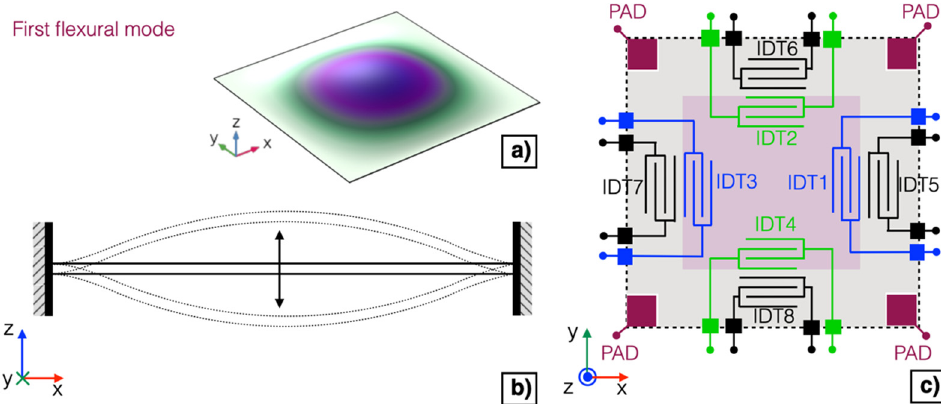
Figure 4. Displacement ( a ) and section view ( b ) of a fully-clamped square plate vibrating at the first flexural mode. Simplified schematic of the proposed piezoelectric MEMS device ( c ).